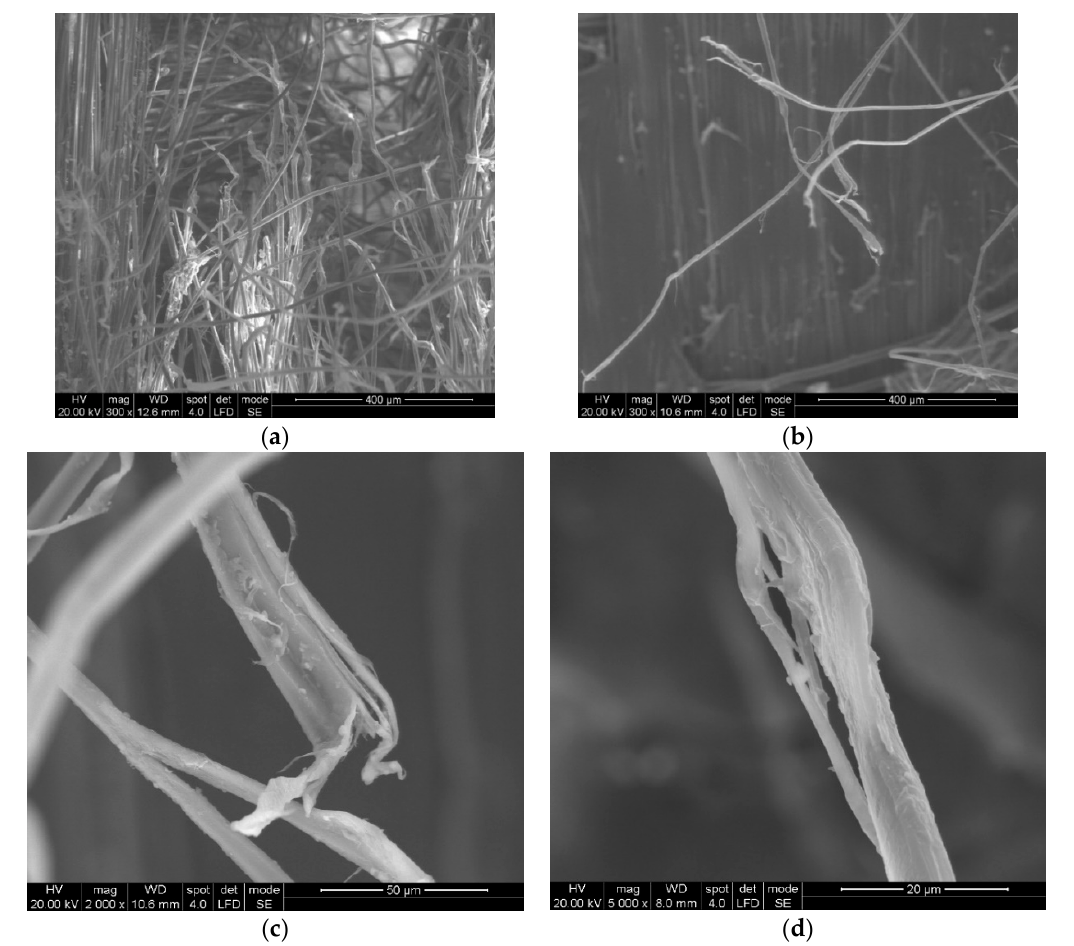
Figure 15. Details of the broken fibrils from the 2nd layer of the LFT SB1plus ballistic package. ( a ) layer 1, front view of the broken fibers, from the impact direction; ( b ) details of layer 1, front view of the broken fibers; ( c ) details of a higher magnification of a fiber; ( d ) details of ( b ) with non-uniform fibrillation and necking.